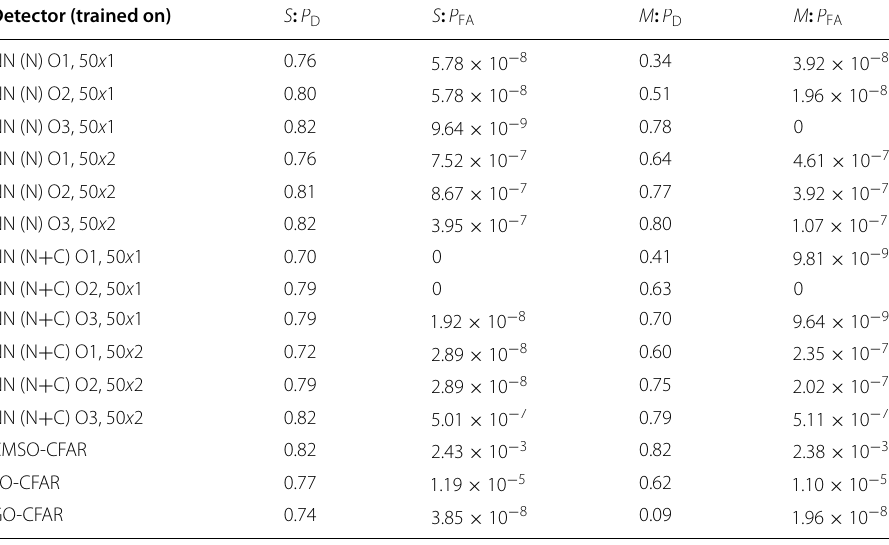
Table 3 Performance comparison, single target ( S ) and multiple close targets ( M ) in noise, P = 6 Detector (trained on)